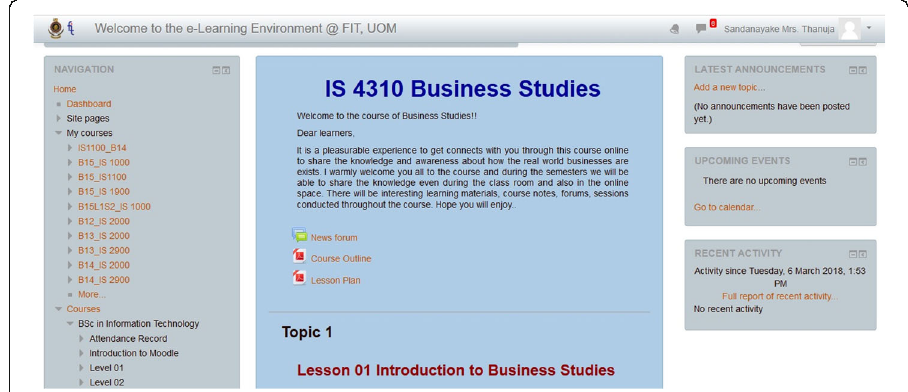
Fig. 1 Moodle interface of the OER-based online